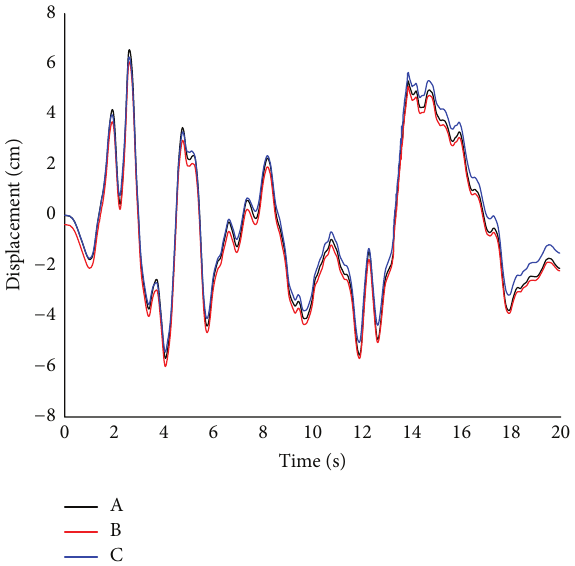
Figure 8: Displacement time curves of monitoring points consider- ing hydrodynamic pressure.